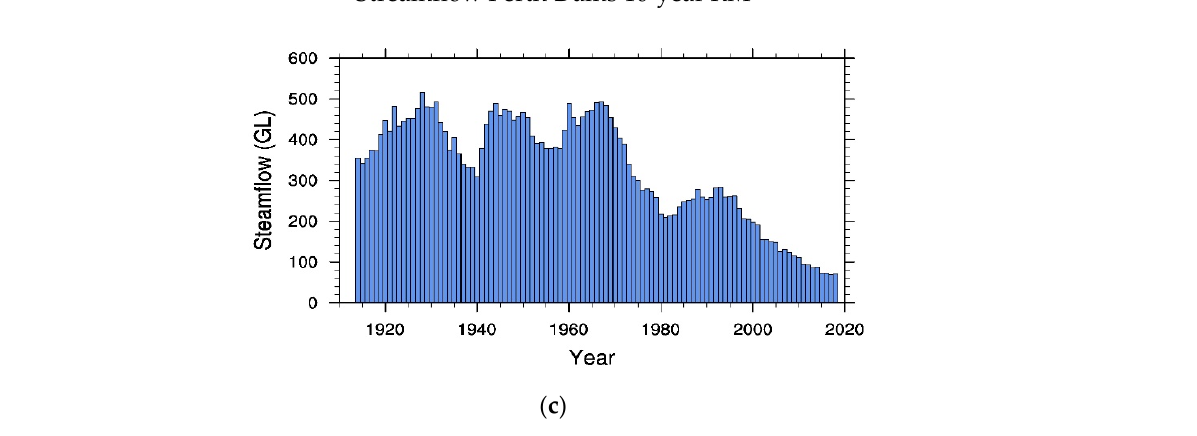
Figure 3. As in Figure 2 for 10-year running means (RM) of ( a ) rainfall, ( b ) decile 10 rainfall and ( c ) streamflow data.